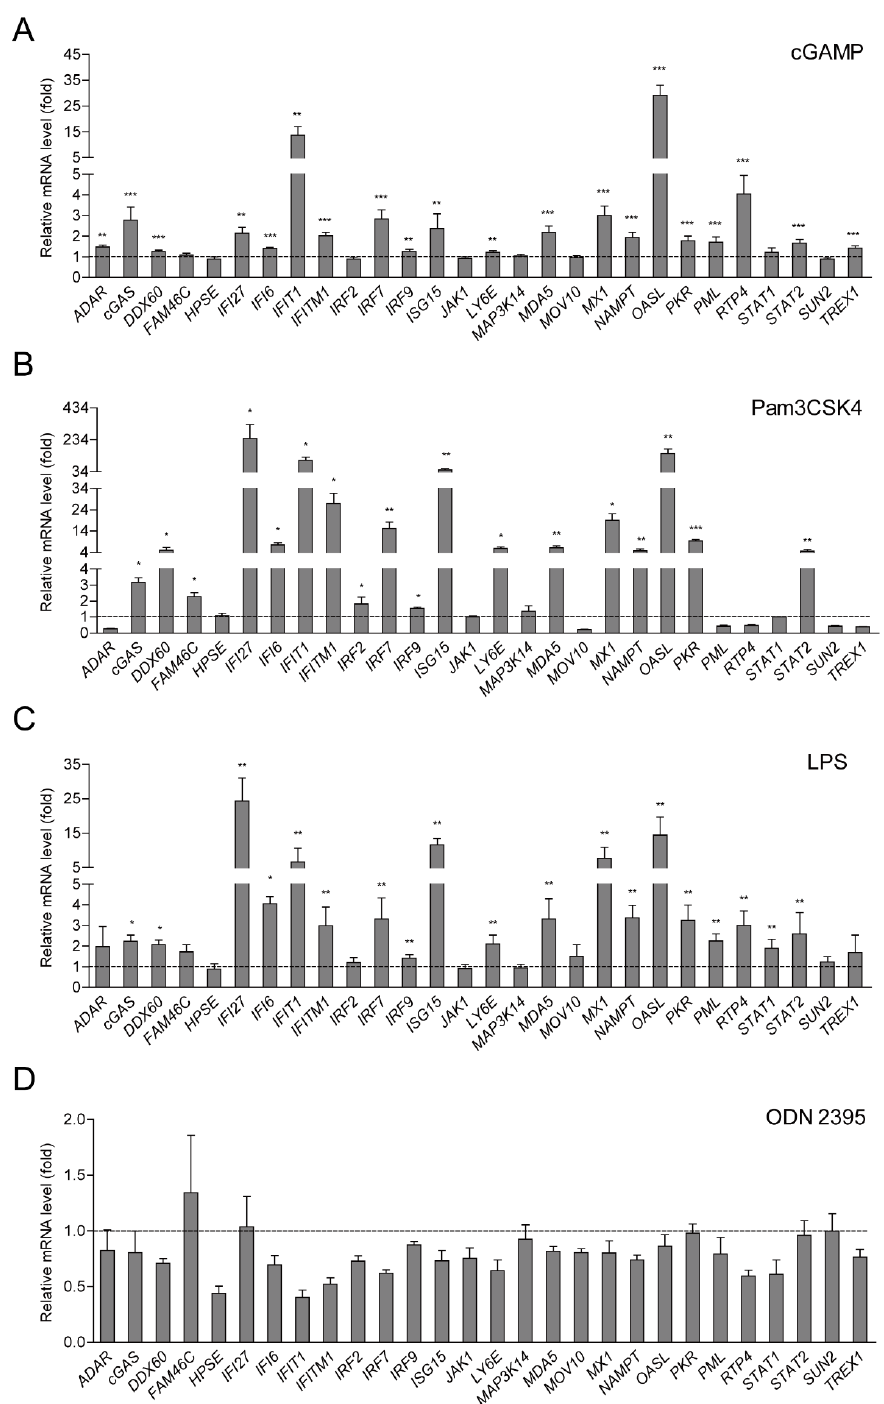
Figure 2. cGAS-STING and TLR-2 and -4, but not TLR-9 signaling pathways are involved in ISG induction in hMDM. ( A ) cGAMP inoculated with lipo2000 as an agonist of cGAS-STING pathway, ( B ) Pam3CSK4 as TLR-2 agonist, ( C ) lipopolysaccharide (LPS) as TLR-4 agonist and ( D ) ODN2395 as TLR9 agonist were treated with hMDMs for 24 h. Data are expressed as mRNA fold change relative to untreated cells. GAPDH served as an internal reference. (Data presented as mean ± SEM, n = 3 independent experiments each with 2 replicates). * p < 0.05, ** p < 0.01 and *** p < 0.001 were considered as statistically